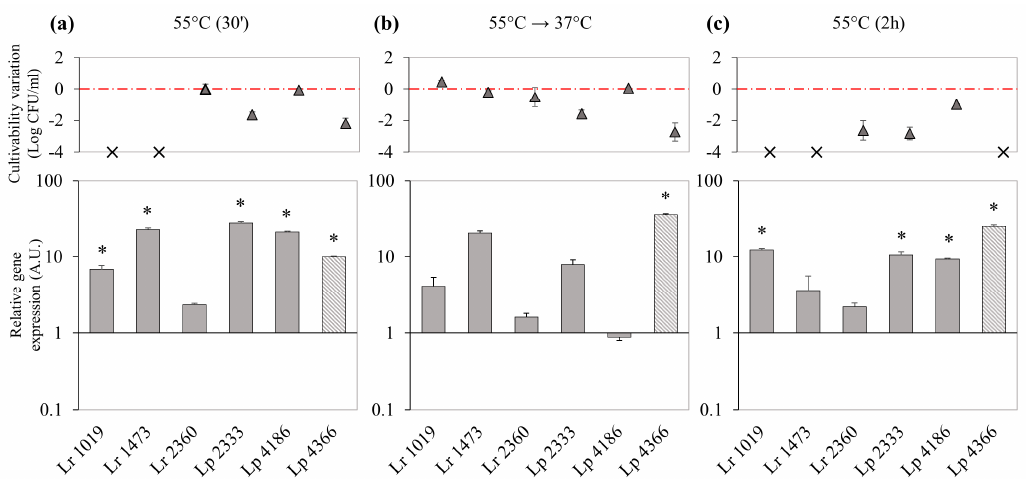
Figure 6. Relative expression of DinJ-YafQ transcript in L. paracasei (Lp) and L. rhamnosus (Lr) strains in response to thermal stress. The upper panels describe, for each strain, the culturability variation reported as the di ff erence between the value measured under the stress condition and that measured in the control condition (gray triangles). The bar graphs below report relative gene expression calculated using 16S rRNA as a reference gene (gray bars), except for L. paracasei 4366 samples that were normalized using gyrB as a reference gene (striped gray bars). For all the strains gene expression was normalized against the control condition, that is not reported. ( a ) incubation at 55 ◦ C for 30 min, ( b ) incubation at 55 ◦ C for 30 min followed by incubation at 37 ◦ C for 90 min, ( c ) incubation at 55 ◦ C for 2 h. X symbols indicate a culturability below the chosen detection limit (5 Log CFU / mL); lower dilutions (until 10 − 2 ) were assayed for these samples but no colonies were observed after 48 h of incubation. Error bars represent the SEM ( n = 2). * significant difference, p < 0.05.